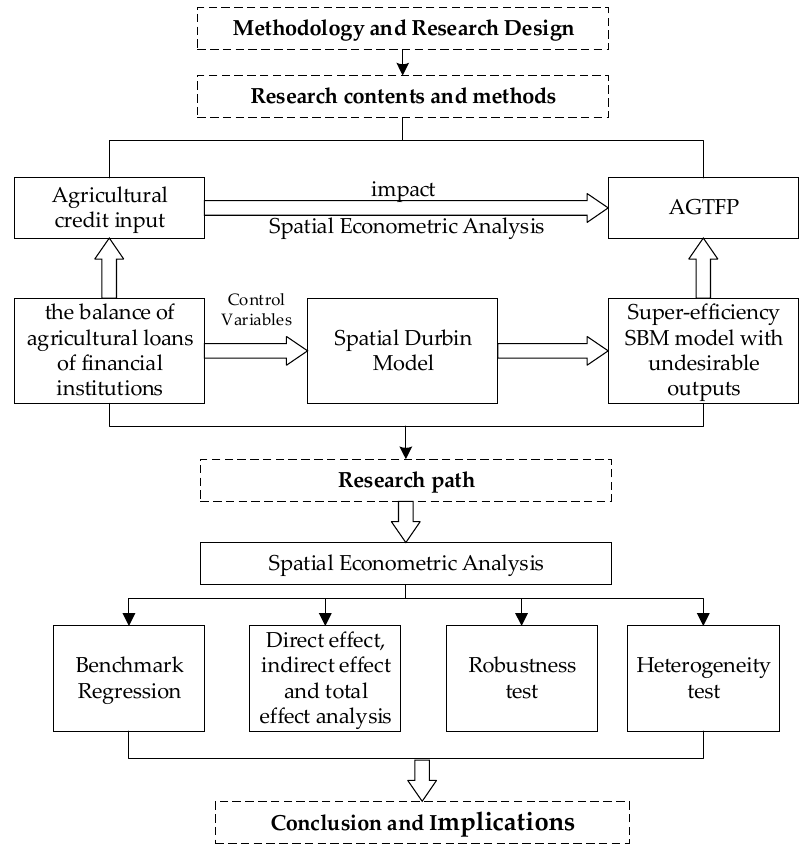
Figure 1. Research Figure 1. Research roadmap. Table 3. The definitions and symbols of all variables.